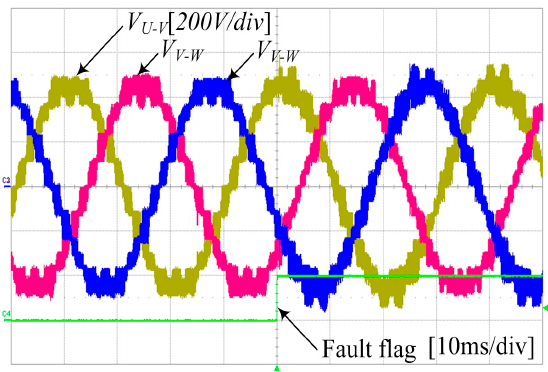
Figure 31. Experimental waveform of line-to-line voltage applying proposed neutral-point voltage-shifting control.